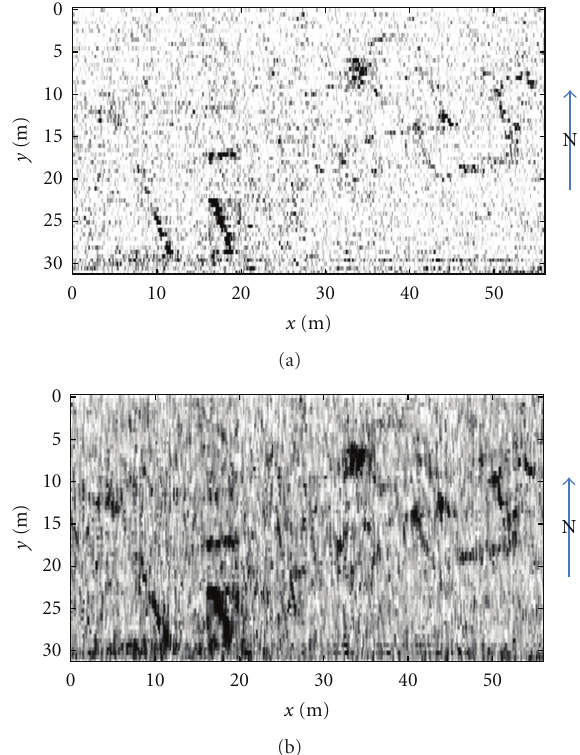
Figure 9: Tomographic constant depth slice at 0.5 m: (a) section not interpolated; (b) section interpolated by a median